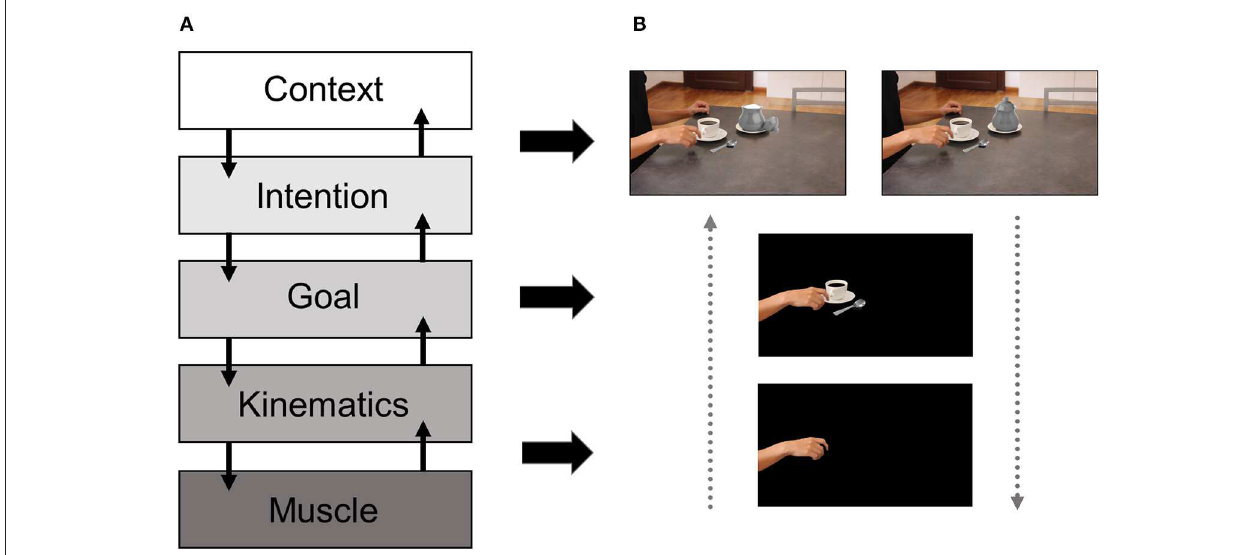
FIGURE 1 | Hierarchical model of action representation and examples of stimuli varying in their level of complexity. The left panel (A) shows the different levels of description at which actions can be understood. Initially, this motor hierarchy included the muscle, the kinematics, the goal and the intention levels (Hamilton and Grafton, 2007 ). More recently, context has been proposed as a higher top-down level assisting intention coding under situations of perceptual ambiguity (Kilner et al., 2007). The right panel (B) shows different versions of the same stimulus varying in the amount of information provided to the observer, from kinematics only to the presence of contextual cues. In the depicted example, without the broader context including the sugar pot either opened or closed, it would be difficult to disambiguate if the precision grip used by the model is directed toward the spoon, hence cueing to the intention of pouring sugar in the coffee or, alternatively, to the handle of the cup, thus cueing to the intention of drinking